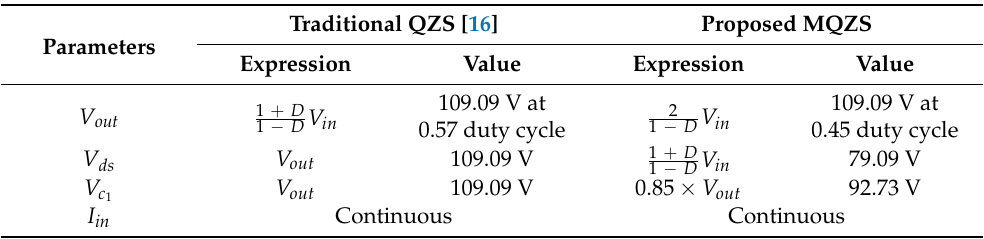
Figure 12. Dynamic response of the MQZS converter. It is fair to compare the suggested converter with the conventional QZS converter. Table 3. Performance comparison among QZS and MQZS converter at V in = 30 V with same Therefore, the converter performance comparison in terms of the capacitor voltage, the output voltage.